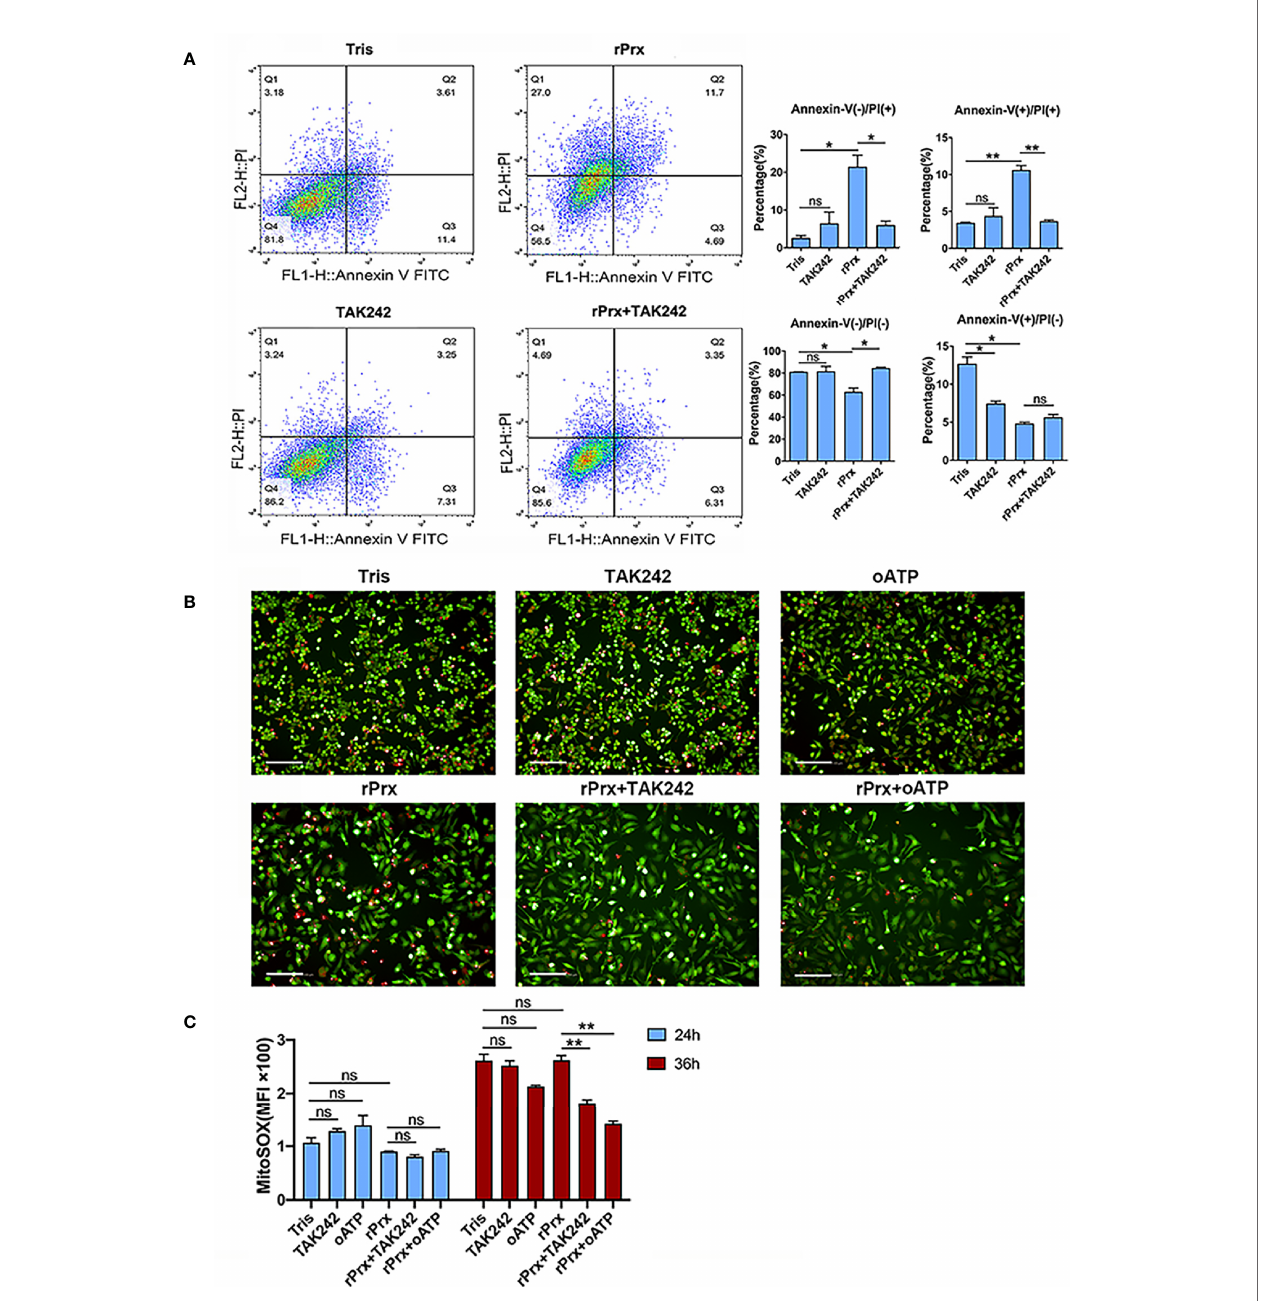
FIGURE 5 | Inhibition of TLR4 receptor blocked apoptosis and mitochondrial oxidative damage induced by Prx. (A) Following pretreatment with TAK242 (1 m M) for 1 h, RAW264.7 cells were incubated with Eh -rPrx (5 m g/ml) for 24 h, then suspended in 500 m L of 1× binding buffer (Sigma-Aldrich, APOAF) at a concentration of 10 6 cells/ml. Following incubation at room temperature for 10 min, 5 m L of Annexin V FITC conjugate (Sigma-Aldrich, APOAF) and 10 m L of propidium iodide solution (Sigma-Aldrich, APOAF) were added to each suspension. Fluorescence of the cells was immediately determined by using a fl ow cytometer. In all groups, n = 3. Experiments were repeated three times. (B) Quantitative analysis of mitochondrial ROS MFI in RAW264.7 cells treated with rPrx. RAW264.7 cells were pretreated with TAK242 (1 m M) for 1 h or oATP (500 m M) for 2 h. Next, the cells were treated with 5 m g/mL of Eh -rPrx or Tris-HCl (pH 8.0) as the negative control. After 24 h or 36 h of treatment, the live cells were stained with MitoSOX (5 m M) for 10 min, and then with CFSE (2 m M) for counterstaining. The cells were immediately observed and quanti fi ed through high-content screening analysis. In all groups, n = 3. Experiments were repeated three times. (C) The fl uorescence images of RAW264.7 cells after 36 h of rPrx treatment. Red fl uorescence, MitoSOX ™ Red; green fl uorescence, CFSE; scale bar, 100 m m. In all groups, n = 3. Experiments were repeated three times. Statistical analysis was conducted by Student ’ s t -test, and data are expressed as mean ± SEM. *p < 0.05, **p < 0.01, ns, not signi fi